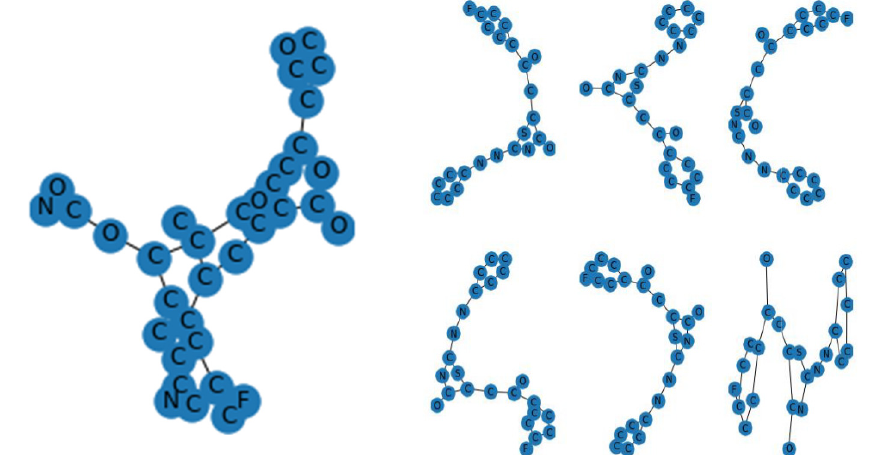
Figure 7. Molecular image of newly generated SMILES using LSTM.